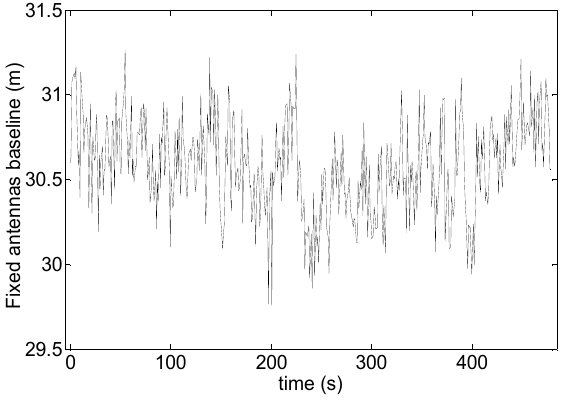
Figure 13. Fixed antennas baseline (DGPS) as a function of time.